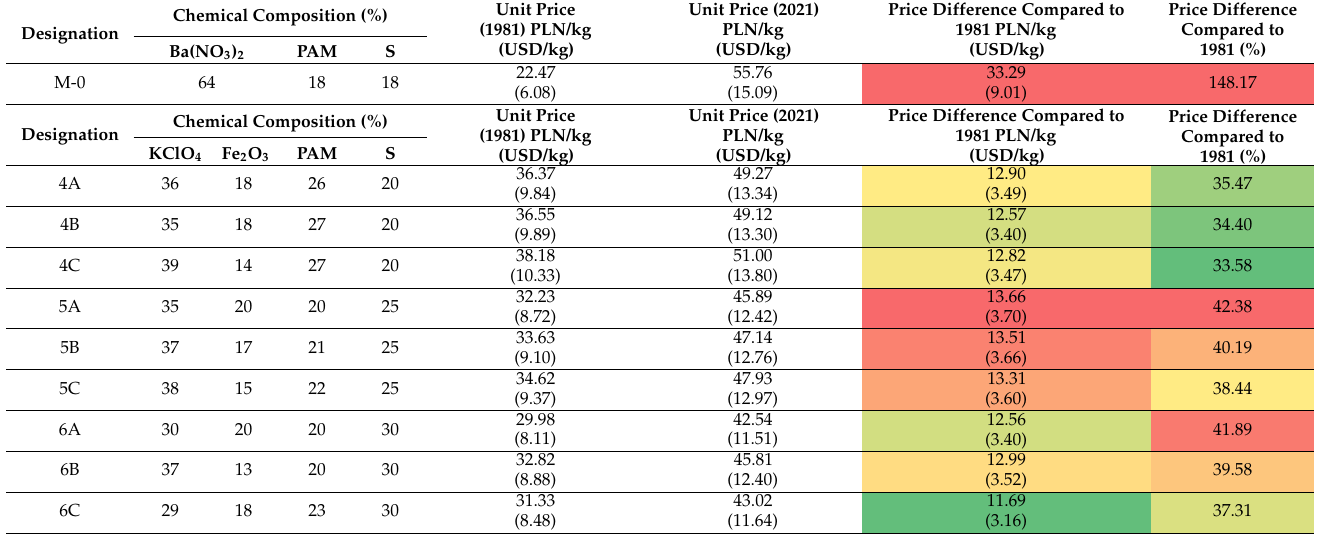
Table 8. Analysis of changes in unit prices of pyrotechnic compositions from M-2 group and M-0 comparison